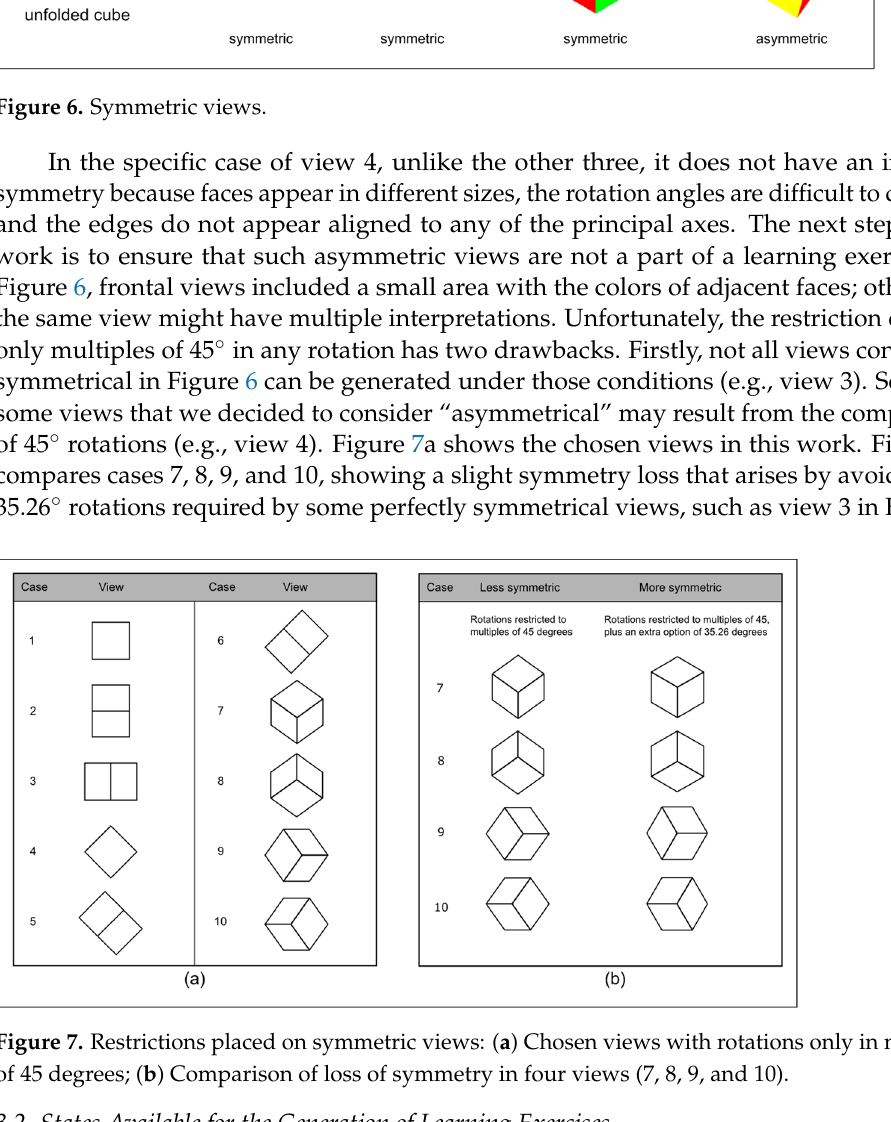
Figure 6. Symmetric views.